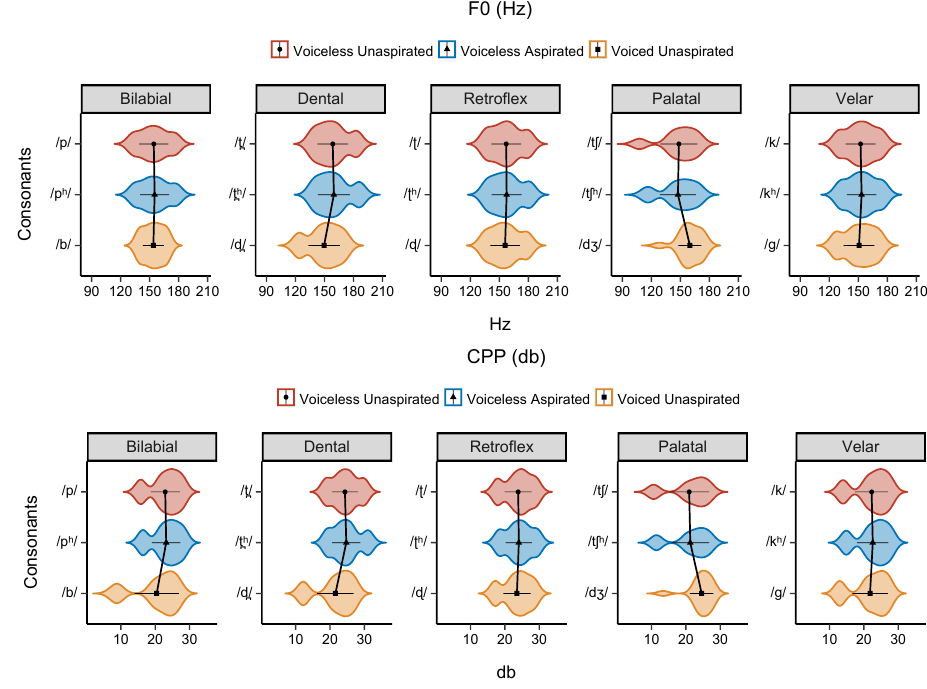
Figure 3. Violin plots of F0 and CPP. Black lines connect the means of the three laryngeal categories (voiceless unaspirated, voiceless aspirated, and voiced unaspirated) at each place of articulation (bilabial, dental, retroflex, palatal, and